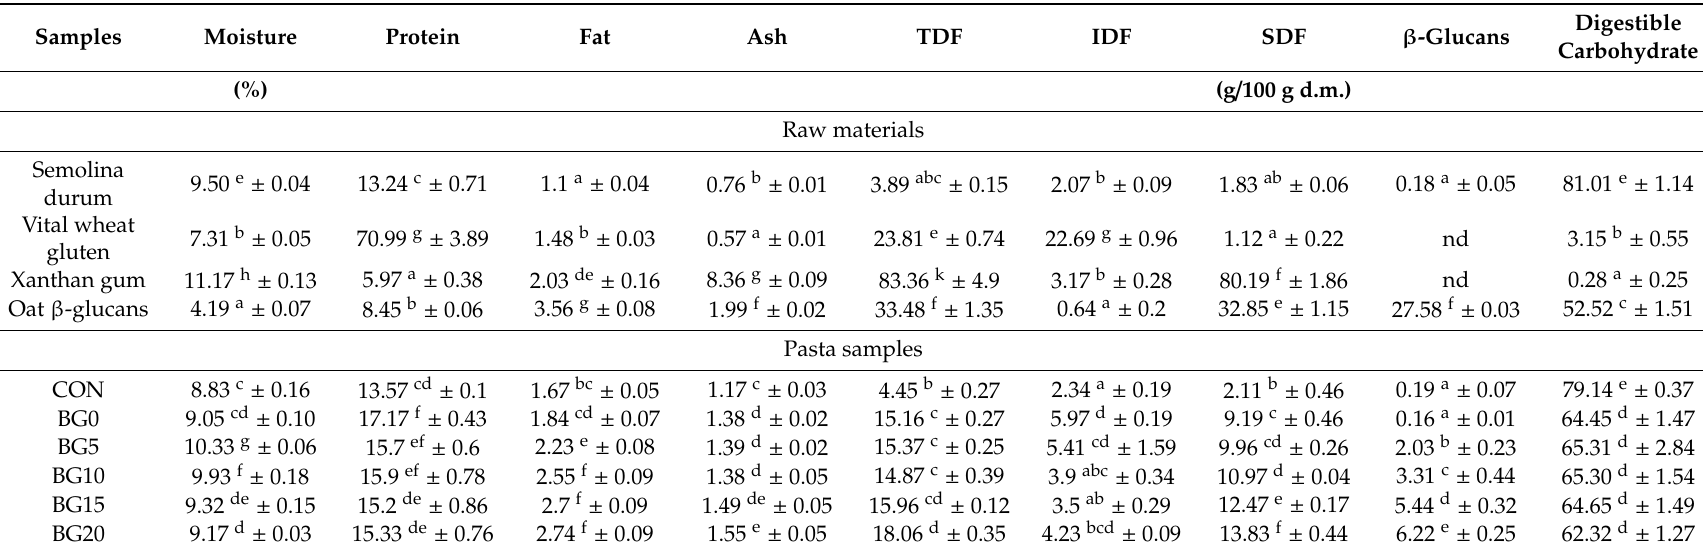
Table 2. Chemical composition of raw material and pasta